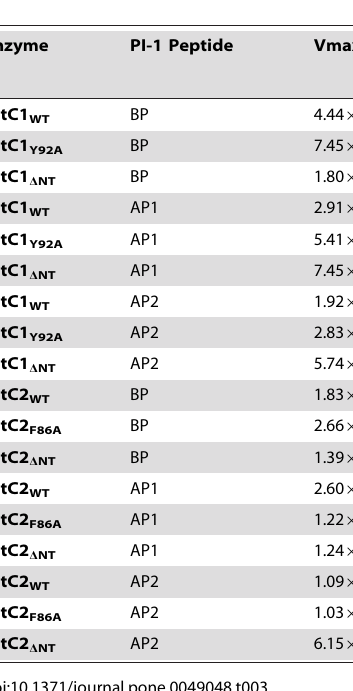
Table 3. Kinetic constants Km, Vmax and Kcat of wild-type and mutant sortases.